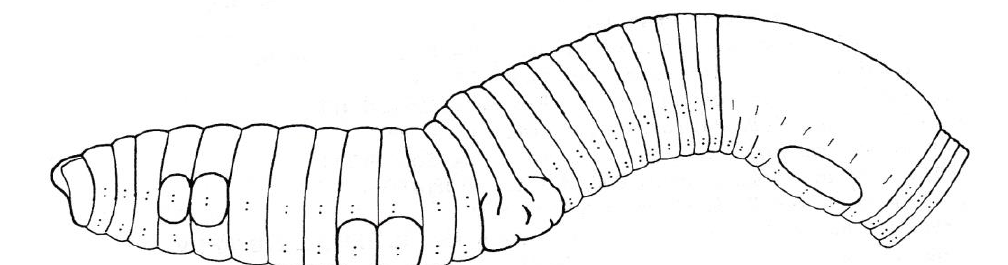
Figure 1. Anterior part of the body of species Lumbricus meliboeus (Mršić, 1991)